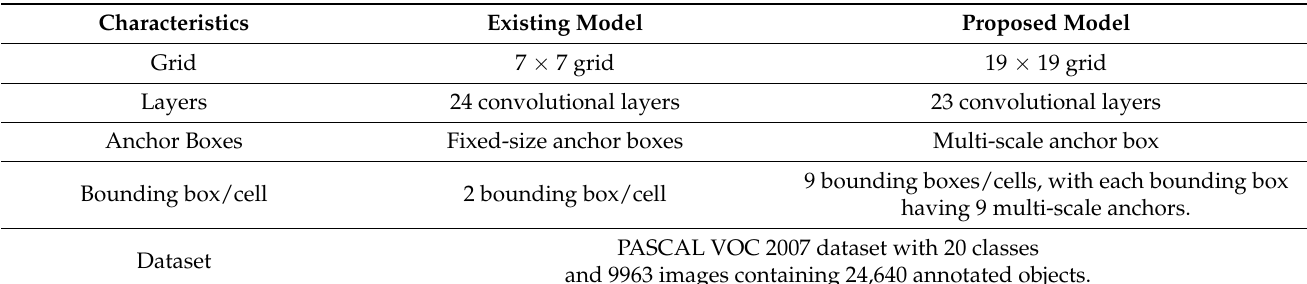
Table 3. Comparison of the existing model with the proposed model on various parameters.